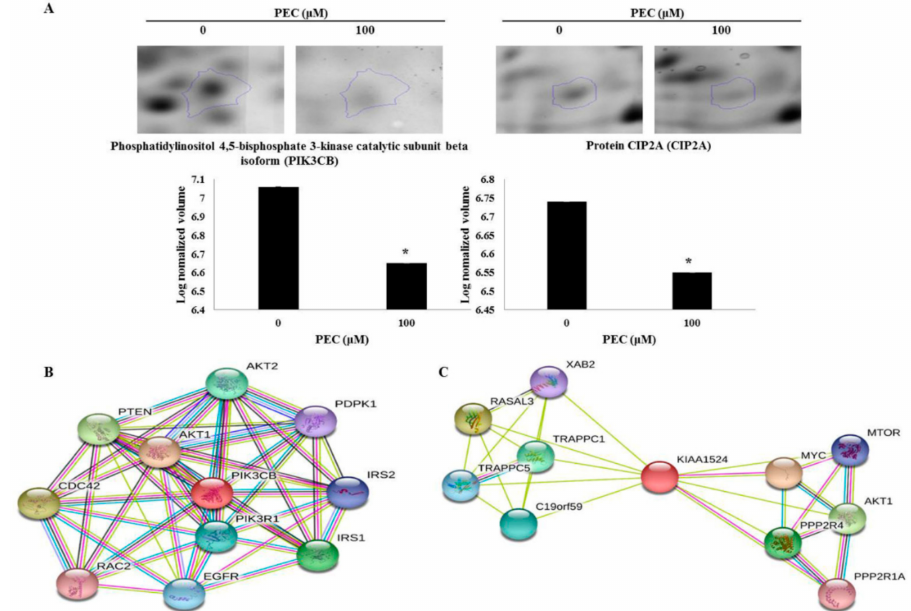
Figure 6. Expression profiles of magnified two-dimensional gel electrophoresis spots identified in pectolinarigenin-treated MKN28 cells. ( A ) The spots of PIK3CB and CIP2A are differentially expressed in MKN28 cells. Gels were scanned and image analysis was performed using Progenesis Samespots software. The spots differing significantly in their intensities (fold-change ≥ 1.5) in pectolinarigenin-treated AGS and MKN28 cells, as compared with untreated control cells. ( B ) PIK3CB and ( C ) CIP2A are related with PI3K/AKT/mTOR pathway in STRING database (high confidence level: 0.700 developed 10 signaling modules). The data are shown as the mean ± standard deviation of three independent experiments (* p < 0.05 vs.